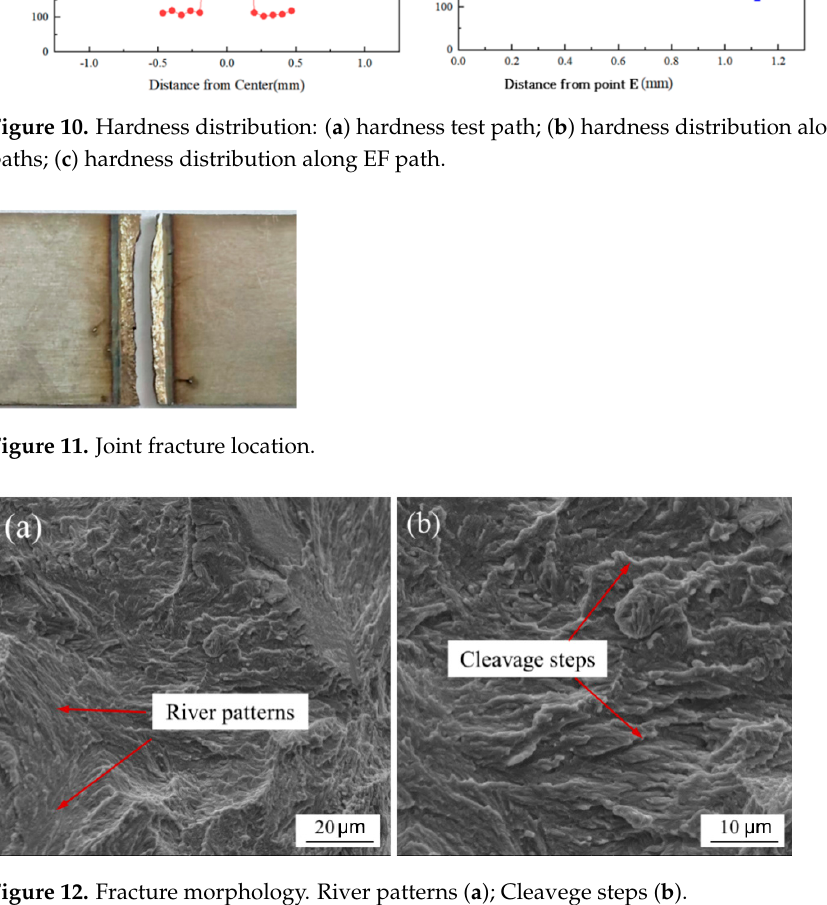
Table 8. Calculated elastic constants.